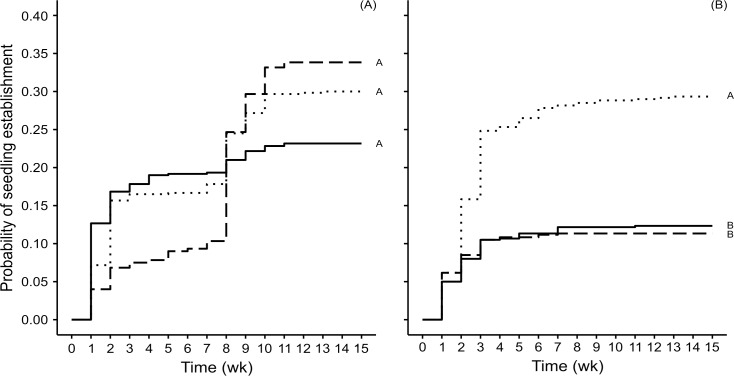
Kaplan–Meier curves for the probability of seedlings establishing from experimental seeds of two plant species.During 15 weeks, seedling establishment was monitored for Bursera (A) and Poulsenia (B) in plots containing: 50 g of feces and dung beetle access (solid black lines), 50 g of feces and dung beetle exclusion (dashed black lines), and without feces or dung beetles (dotted black lines). In the first two treatments 20 seeds were mixed in the dung, and in the last treatment seeds were placed on the soil surface. All curves have censored data. Different letters next to each curve indicate statistical differences.